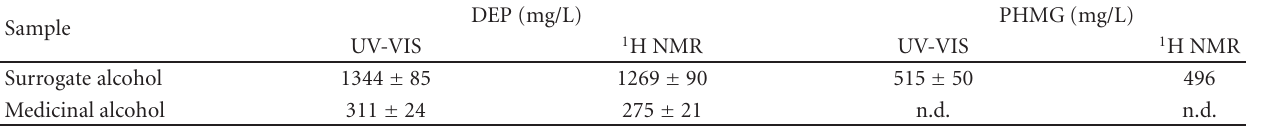
Table 1: Results of DEP and PHMG quantification in unrecorded alcohol samples from Russia ( n = 5). Sample